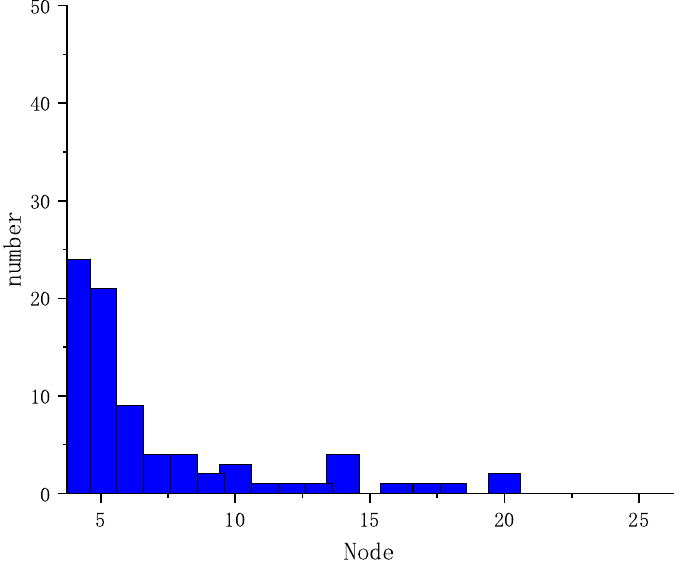
Figure 16. Degree distribution of SF